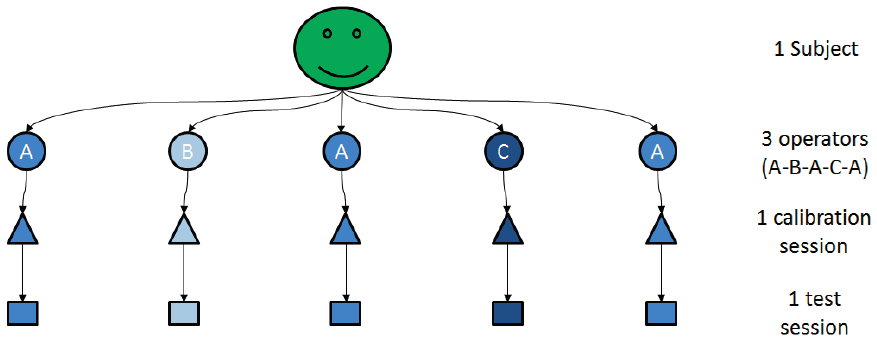
Figure 1. Experimental protocol for one subject.